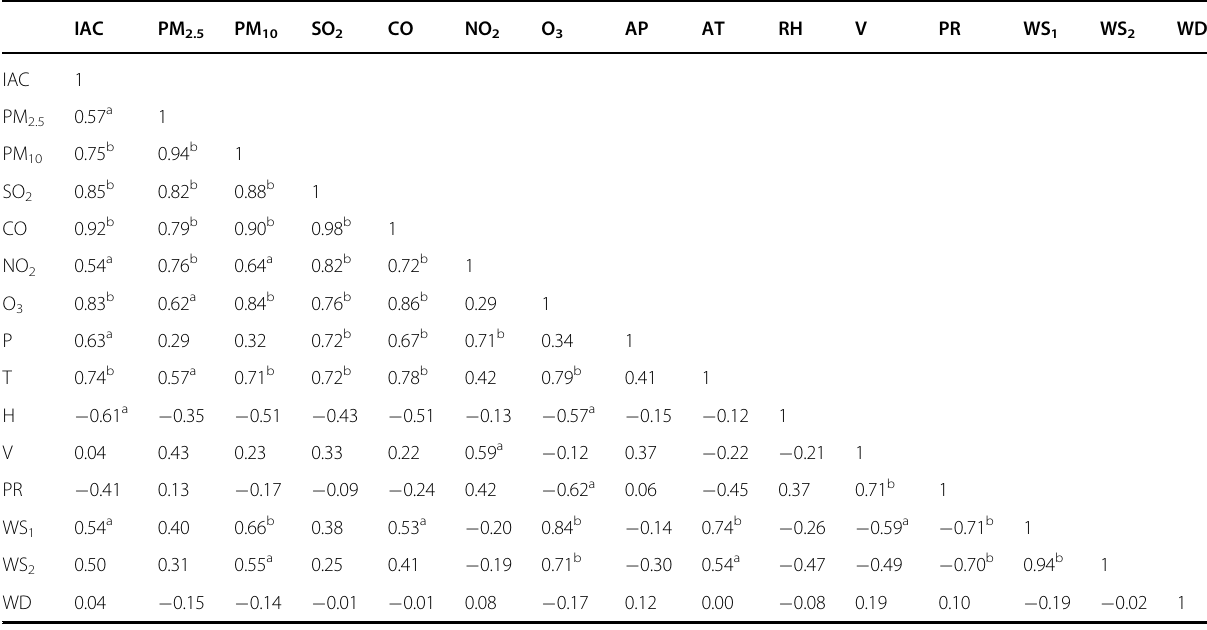
Table 2 Correlation coef fi cients among the IAC, atmospheric pollutants (i.e., PM 2.5 , PM 10 , SO 2 , CO, NO 2 , and O 3 ) and meteorological factors (i.e., Air pressure, Air temperature, Relative humidity, Visibility, Precipitation, Wind speed, and Wind